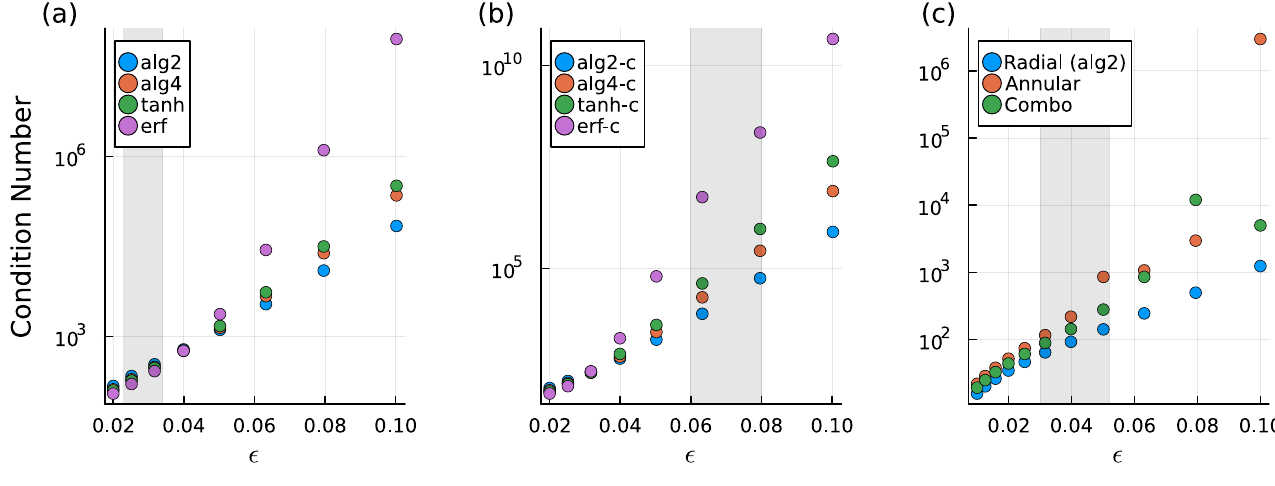
Figure A1. Skeel’s condition number for the inverse problem of a translating sphere described in Section 2.5 using ( a ) uncorrected radial, ( b ) corrected radial, and ( c ) surface-oriented regularizations. For the radial ( a , b ) and surface-oriented ( c ) regularizations, n = 4096 and n = 1024 discretization points are used, respectively. The shaded regions indicate the values of (cid:101) where the error in the drag is approximately